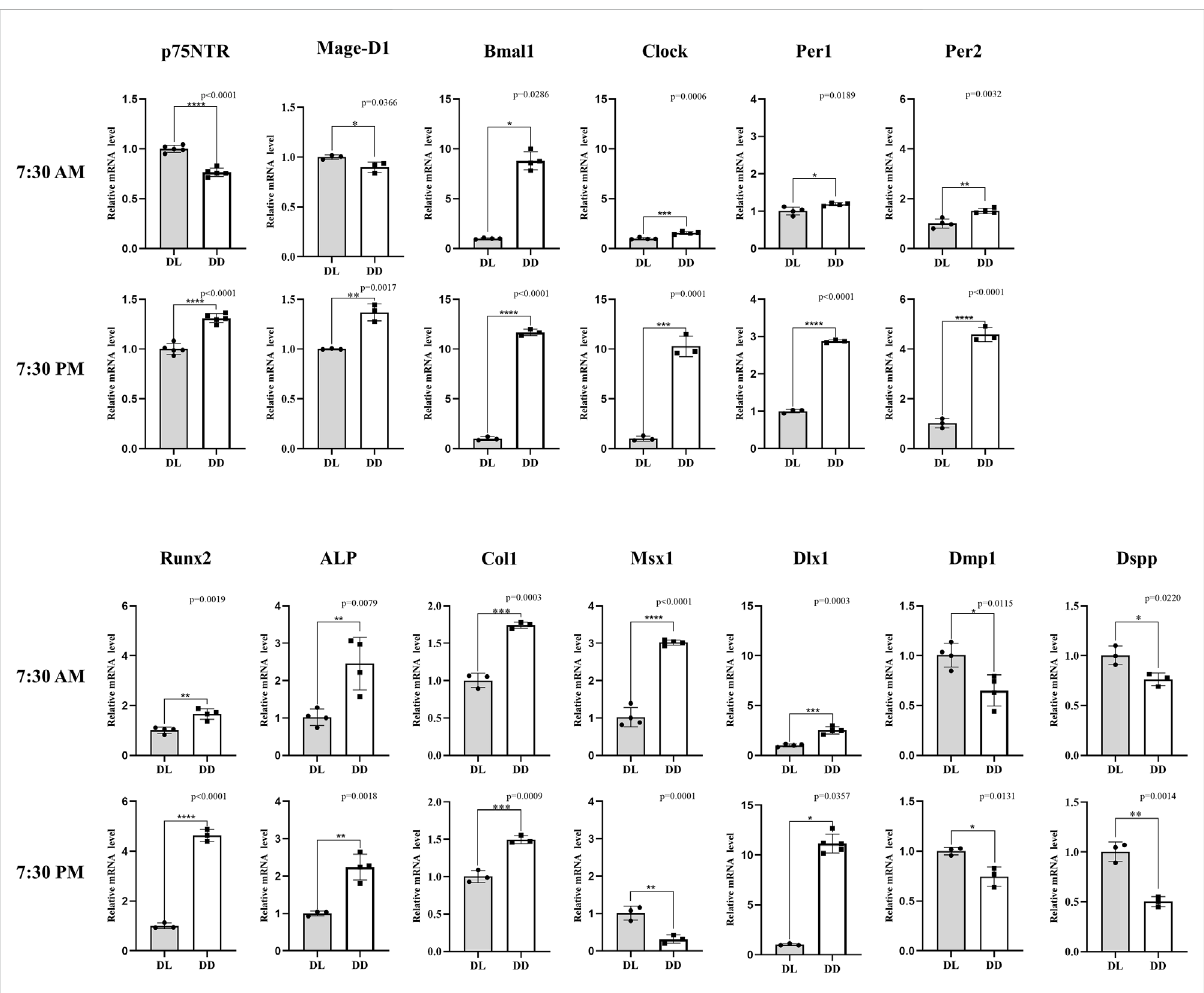
FIGURE 5 The in vivo observation of circadian rhythm dynamics in PN7 d dental germs of wild-type mice. p75NTR mRNA showed a signi fi cant difference between D.D. and L.D. conditions ( p < 0.05), but the change tendencies at two sampling times were opposite: p75NTR mRNA expression in the L.D. conditionwassigni fi cantlyhigherat7:30a.m.andsigni fi cantlylowerat7:30p.m.intheD.D.condition( p < 0.05).TheexpressionpatternofMage-D1 wassimilar tothat ofp75NTR.Mostfactors ( Bmal1 , Clock , Per1 , Per2 , Runx2 , ALP , Col1 ,and Dlx1 )showed thesame changetendencyatthetwo sampling times: mRNA expression was signi fi cantly higher in the D.D. condition than that in the L.D. condition ( p < 0.05). The change amplitudes of Clock , Per1 , Per2 , Runx2 , and Dlx1 were signi fi cantly larger at the sampling time of 7:30 PM. Contrary to p75NTR , Msx1 mRNA expression in the L.D. conditionwassigni fi cantlylowerat7:30a.m.andsigni fi cantlyhigherat7:30p.m.comparedwiththeD.D.condition( p < 0.05). Dmp1 and Dspp mRNA expressionintheD.D.conditionwassigni fi cantlylowerthanthatinL.D.conditionatbothsamplingtimes( p < 0.05).Allexperimentswererepeatedat least three times independently. Data are expressed as mean ± S.D. L. D. Condition group, n = 11; D. D. Condition group, n =